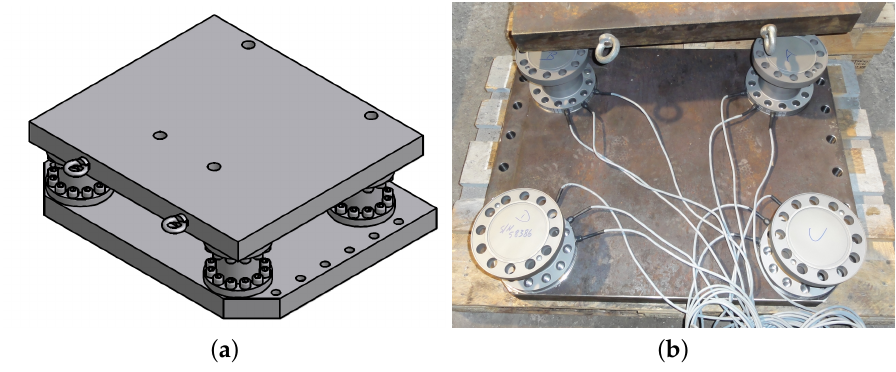
Figure 10. ( a ) Sensor unit consisting of two 80 mm steel plates with four triaxial force sensors mounted between them; ( b ) Arrangement of sensors on steel plate with measuring leads directed